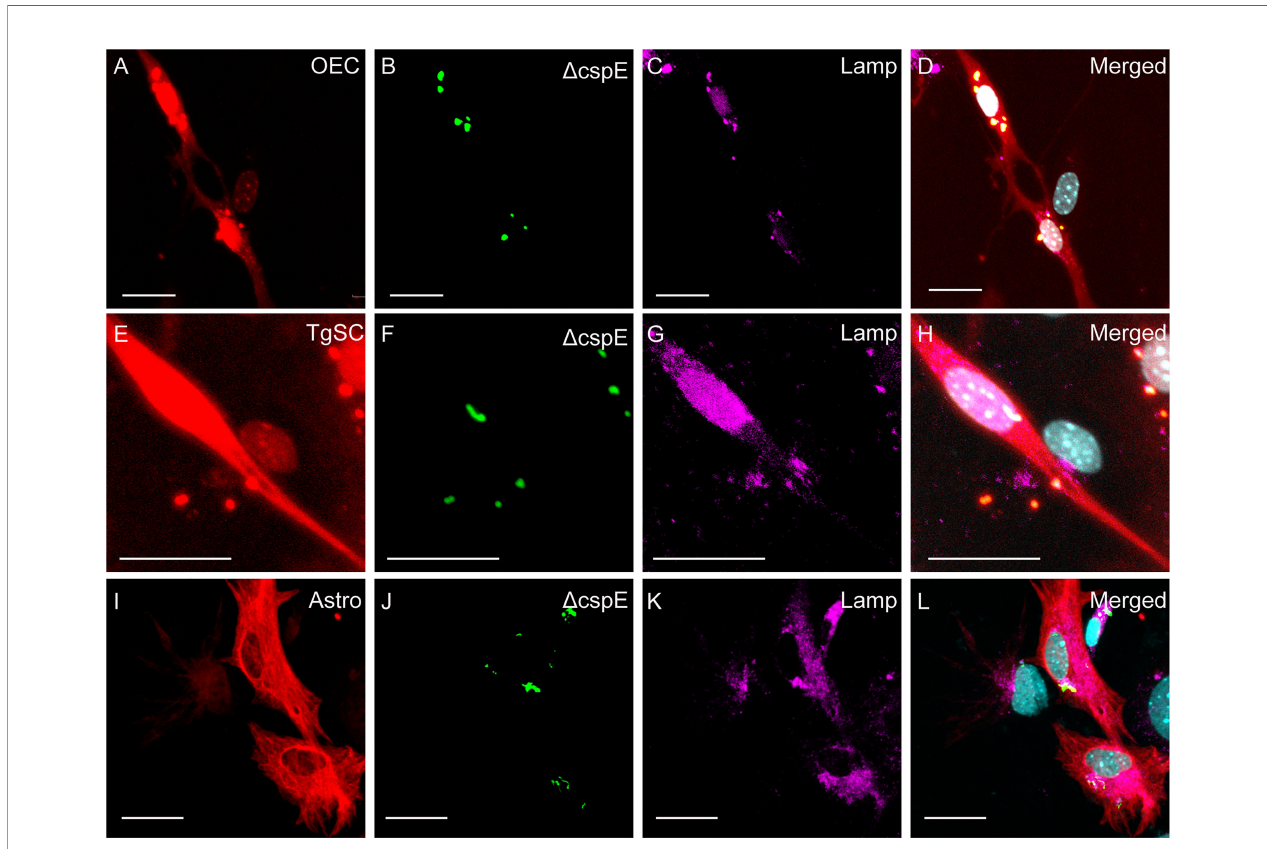
FIGURE 7 | Phagocytosis of D cpsE S. agalactiae in phagolysosomes in glial cells (OECs, TgSCs and astrocytes) 24 h post infection. Panels show primary cultures of OECs (A – D) , TgSCs (E – H) and astrocytes (I – L) from S100 b -DsRed mice. OEC and TgSCs were visualised by DsRed expression (red), whilst astrocytes were immunolabelled for GFAP (red). Nuclei are stained with Hoechst. (B, F, J) shows S. agalactiae within cells, (C, G, K) LAMP-2 immunolabelling for lysosomes, and (D, H, L) S. agalactiae colocalizes with LAMP-2 showing the bacteria is internalized in phagolysosomes. Scale bar: 25 m